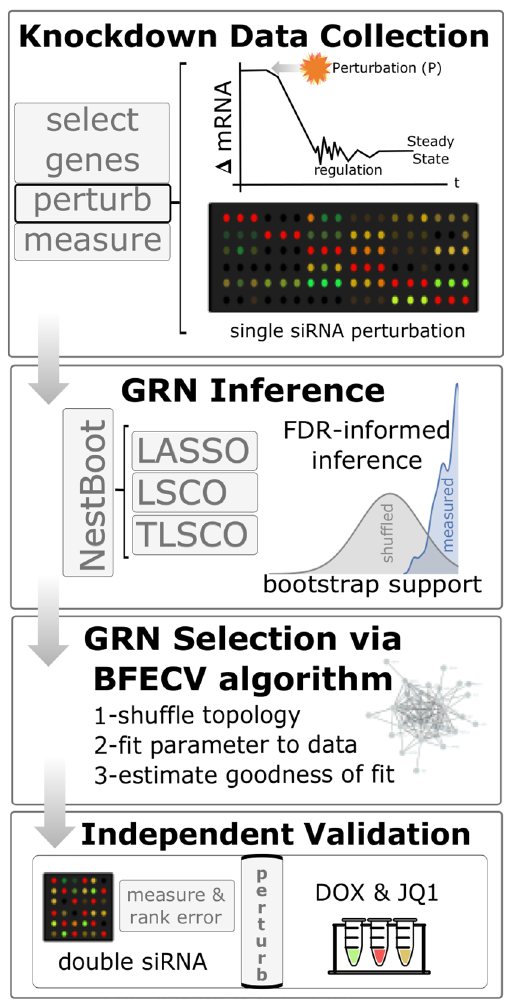
Figure 1. Workflow of project. siRNA perturbation experiments were carried out systematically per gene, resulting in a change in mRNA level which elicits a regulatory response over time before reaching steady state when gene expression was measured. GRN inference: nested bootstrapping was applied to three inference methods, producing GRNs with an FDR set to 5%. GRN Selection: Estimate goodness of fit with the Balanced Fitting of Errors framework under cross-validation (BFECV) and compare to shuffled topologies (Algorithm 1). Independent Validation: Each inferred GRNs’ ability to predict an independent dataset was evaluated in comparison to a distribution of shuffled topologies. Finally, the overall most predictive GRN was selected. Two novel links were experimentally